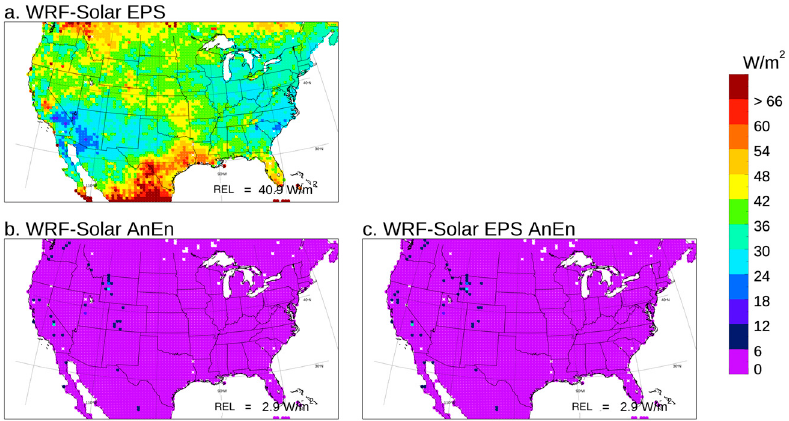
Figure A7. Potential continuous ranked probability score (CRPSPOT) map computed for DNI pooling runs and the forecast lead times from +24 to +48 h for 2018 together.